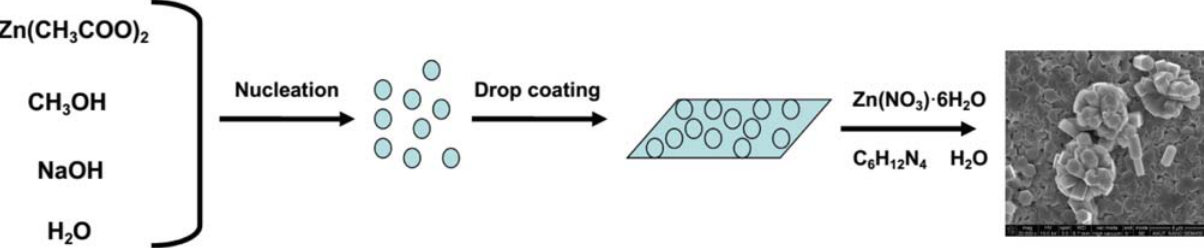
Fig. 2. Schematic process for fabricating ZnO